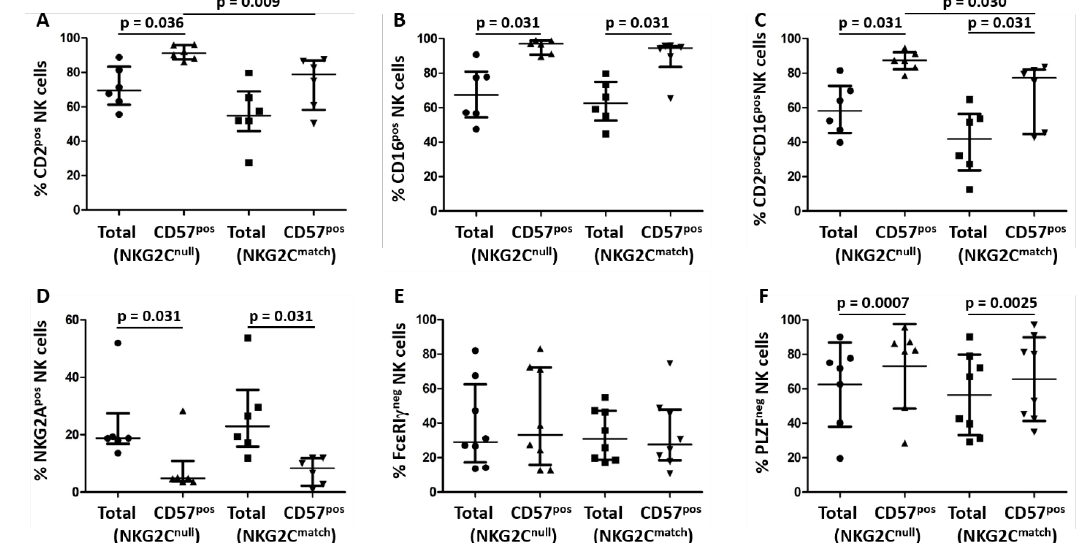
Figure 2. The maturation pattern of NK cells from the NKG2C null and NKG2C match groups. The same